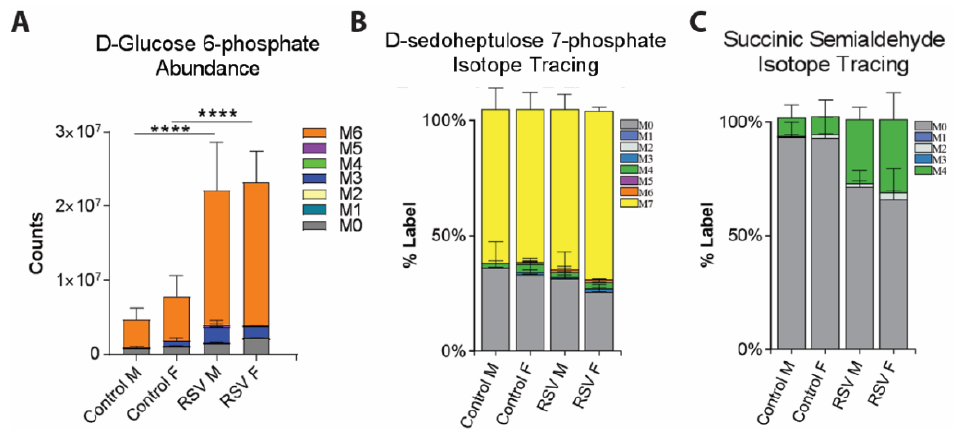
Figure 5. ( A ) Mass spectrometry analysis of intracellular abundance of d-glucose 6-phosphate (an immediate glucose metabolite) showing increased glycolysis in RSV group NAECs. ( B ) Isotope tracing analysis of conversion of 13C glucose to pentose phosphate pathway intermediate d-sedoheptulose 7-phosphate. Color bars indicate the proportion of metabolite derived from de novo 13C glucose uptake (indicated by number of 13C incorporated carbons (M1-M7), gray indicates metabolite production from native upstream metabolic reactions (no incorporated 13C carbons (M0)). ( C ) Higher conversion of 13C glucose to succinic semialdehyde (green bars), suggesting aberrant TCA cycle inputs in NAECs from children who were RSV infected as infants. n = 2 independent donors/group. **** p <0.0001 by two ‐ way ANOVA with Tukey multiple comparisons.